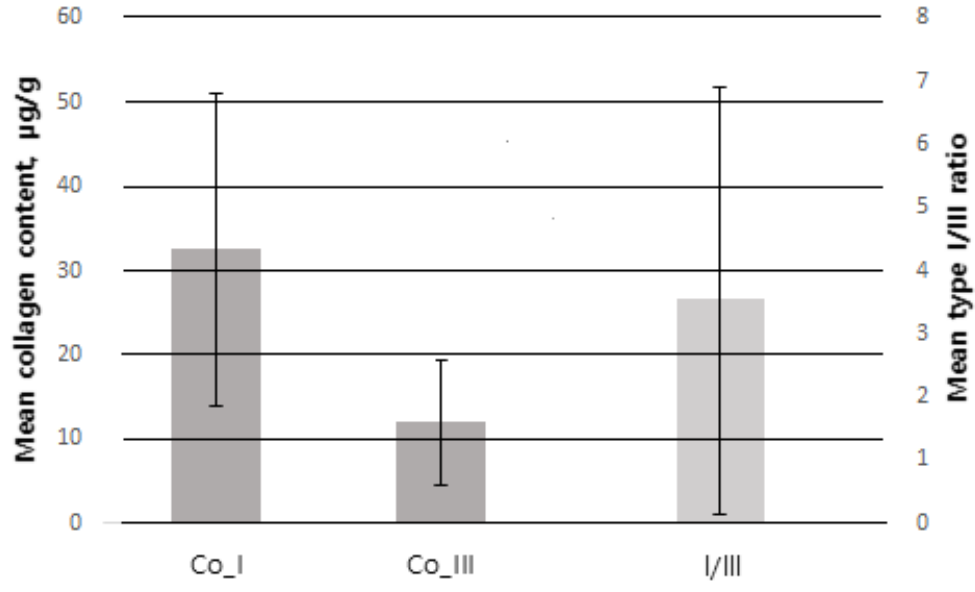
Figure 5. Error bar of SD (standard deviation). Co_I collagen type I (SD = 18.22), Co_III = collagen type III (SD = 6.27) follow the left Y -axis. I/III = collagen type I/III ratio (SD = 3.72) follow the right Y -axis. Table 2. Baseline patient characteristics.